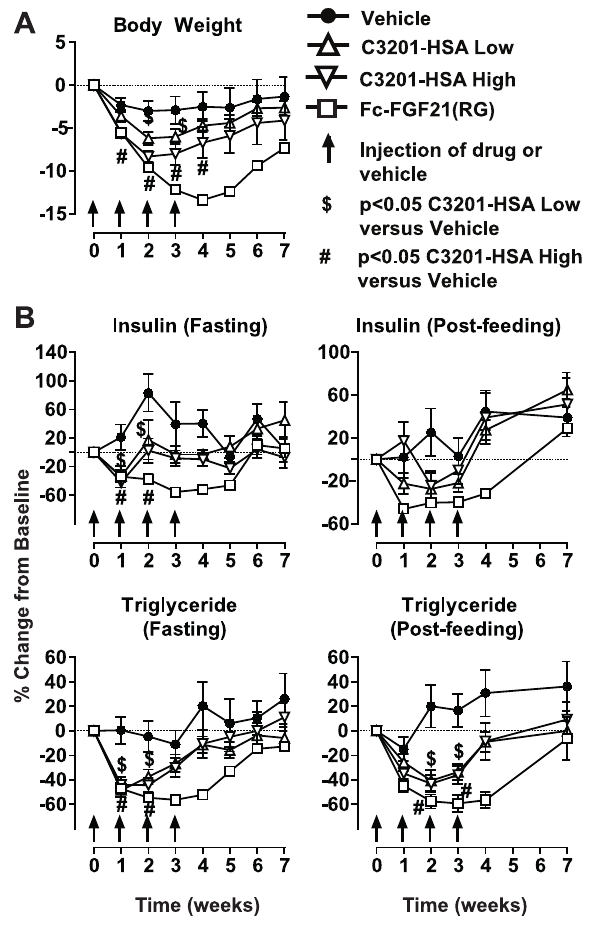
Figure 5. Pharmacodynamic properties of C3201-HSA in obese cynomolgus monkeys. (A) Changes in body weight following administration of vehicle, low or high dose of C3201-HSA or Fc- FGF21. (B) Changes in plasma insulin and triglycerides measured after feeding and overnight fast following administration of vehicle, low or high dose of C3201-HSA or Fc-FGF21. Data are represented as mean + / 2 SEM (n=10).